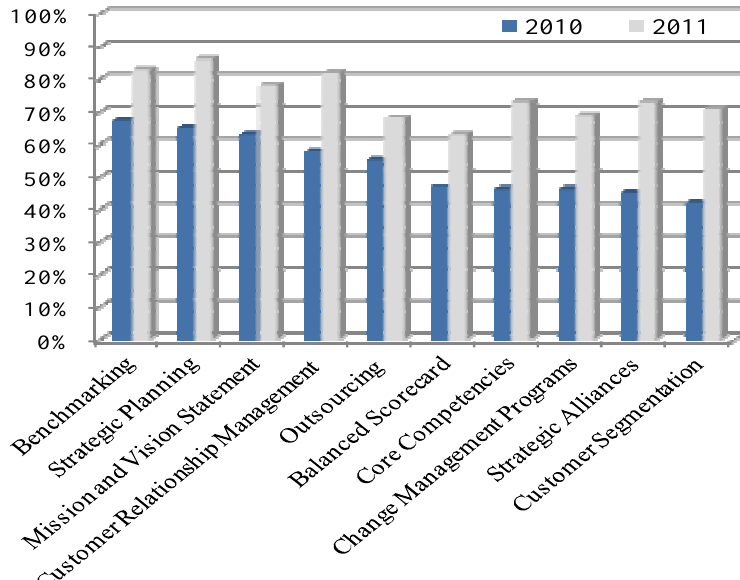
Figure 3 – Expected changes in performance management tools usage (Rigby, Bilodeau,